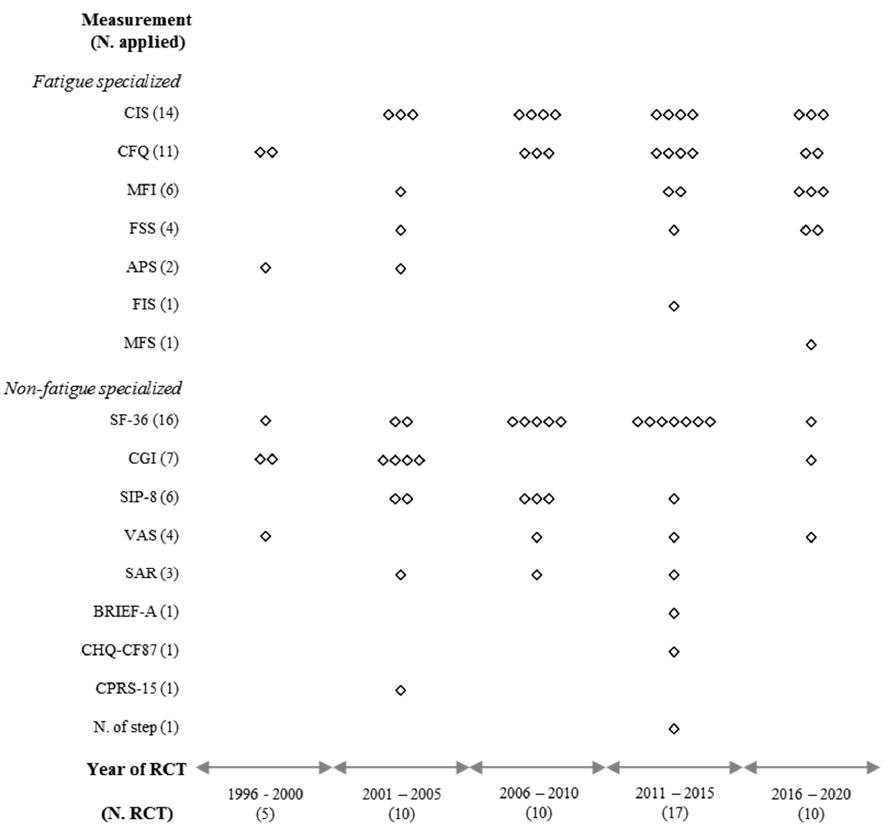
Figure 2. Graphical display for quinquennial distribution of primary measurements. Table 2. Measurement instruments in RCTs.